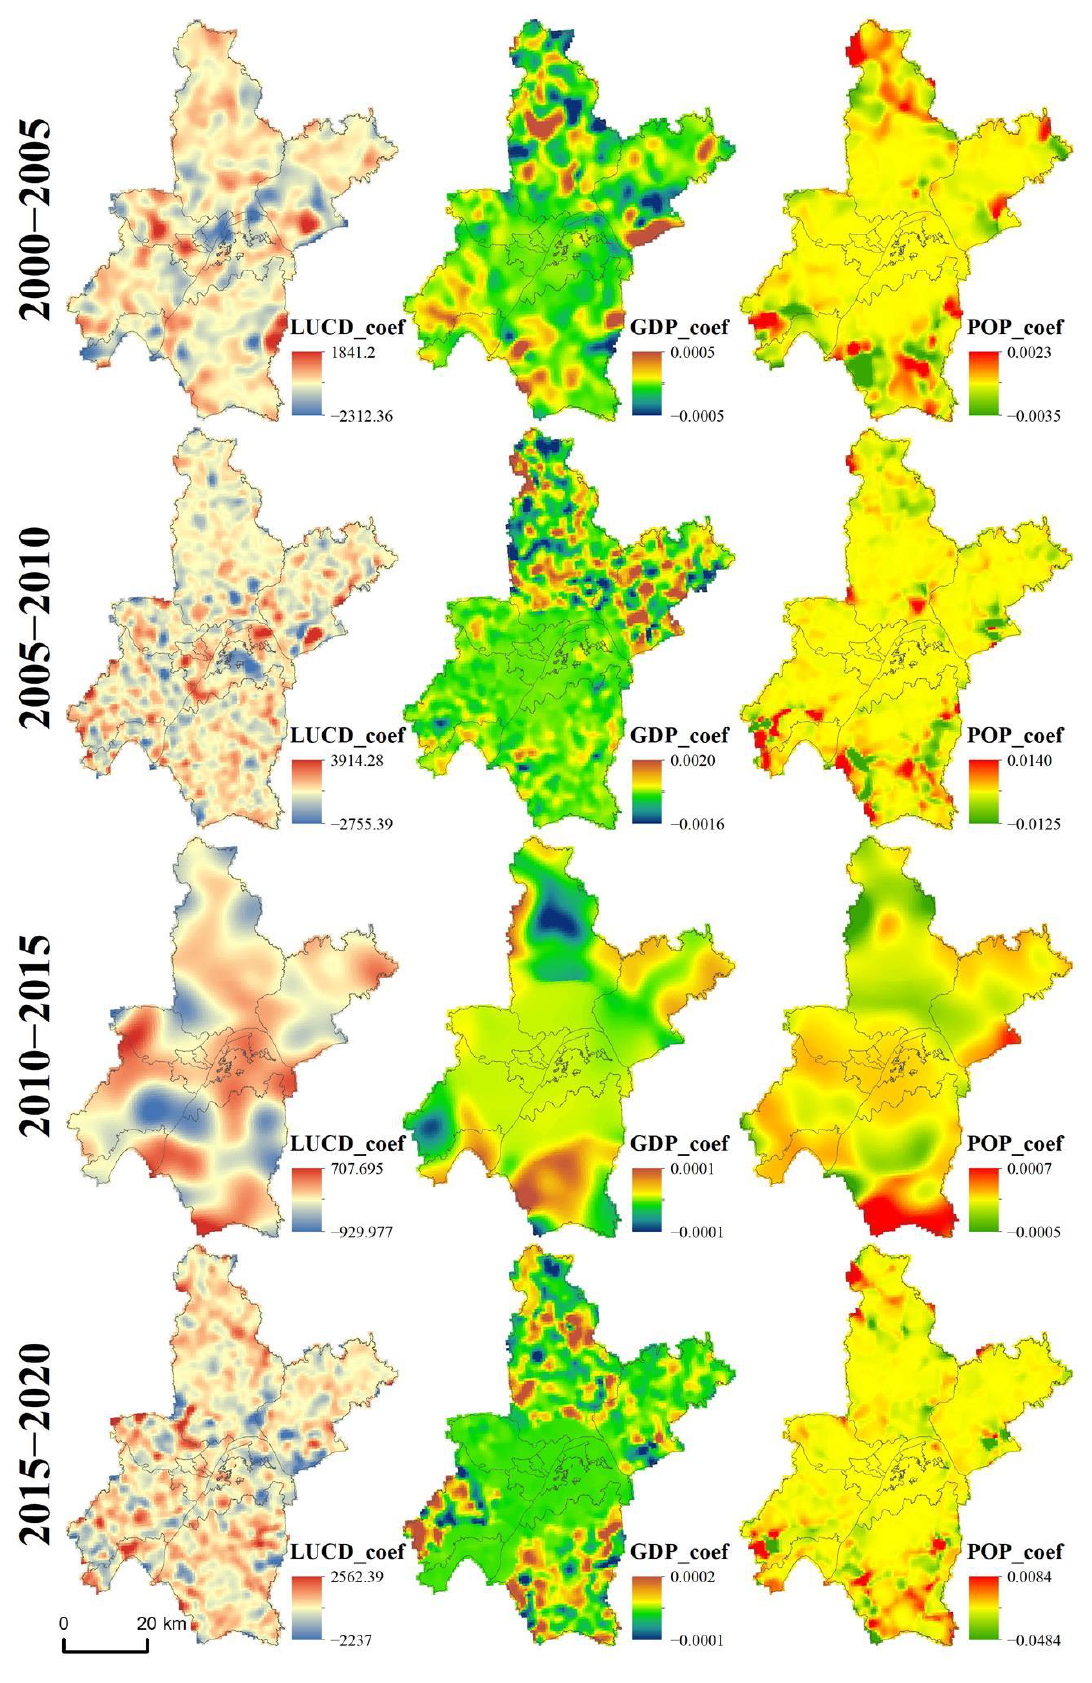
Figure 9. Spatial distributions of the effect of driving factors on WIRSEI from 2000 to 2020 (coef: